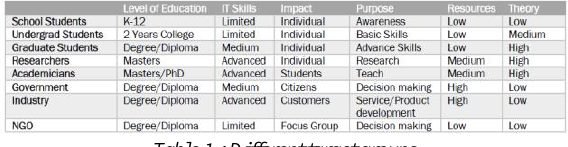
Table 1 : Different target groups